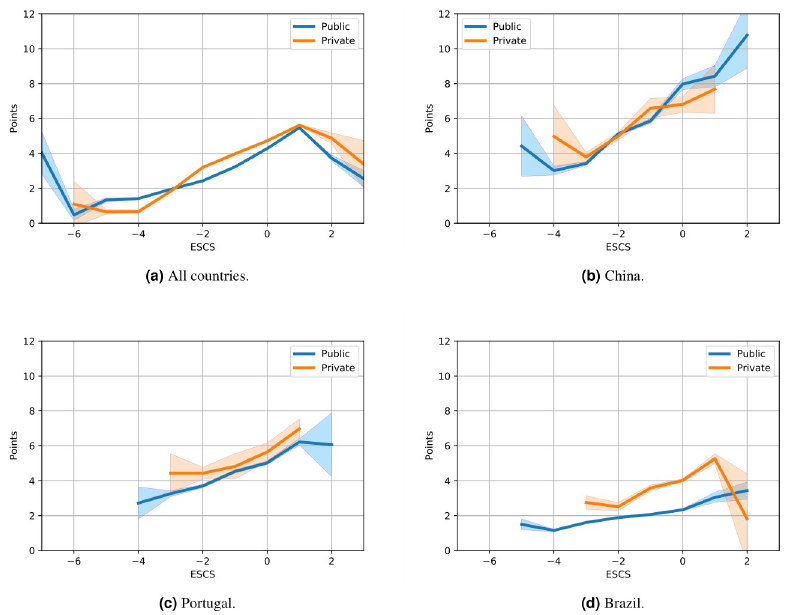
Fig 6. The bootstrapped median values and confidence intervals for the number of points in different intervals of ESCS. The network analysis revealed significant differences between public and private schools in Brazil and Portugal, which here shows as higher results (Points) for private schools. Both Portugal and China have relatively high results for less privileged students (low ESCS), which is why they are clustered together when considering all schools.